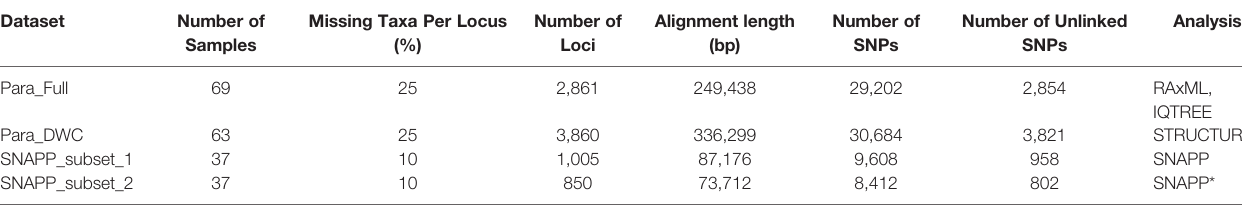
TABLE 3 | Locus statistics from ipyrad output fi les for datasets used in different analyses.